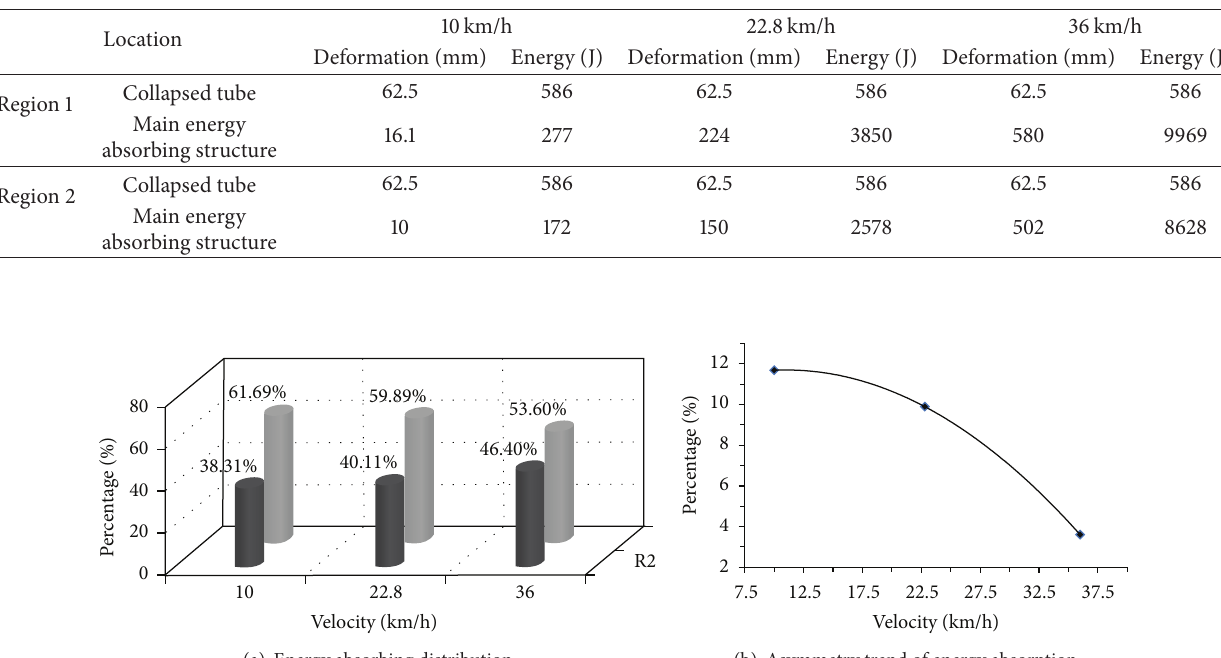
Table 6: Structure deformations and energy absorption of head car at different collision speeds.